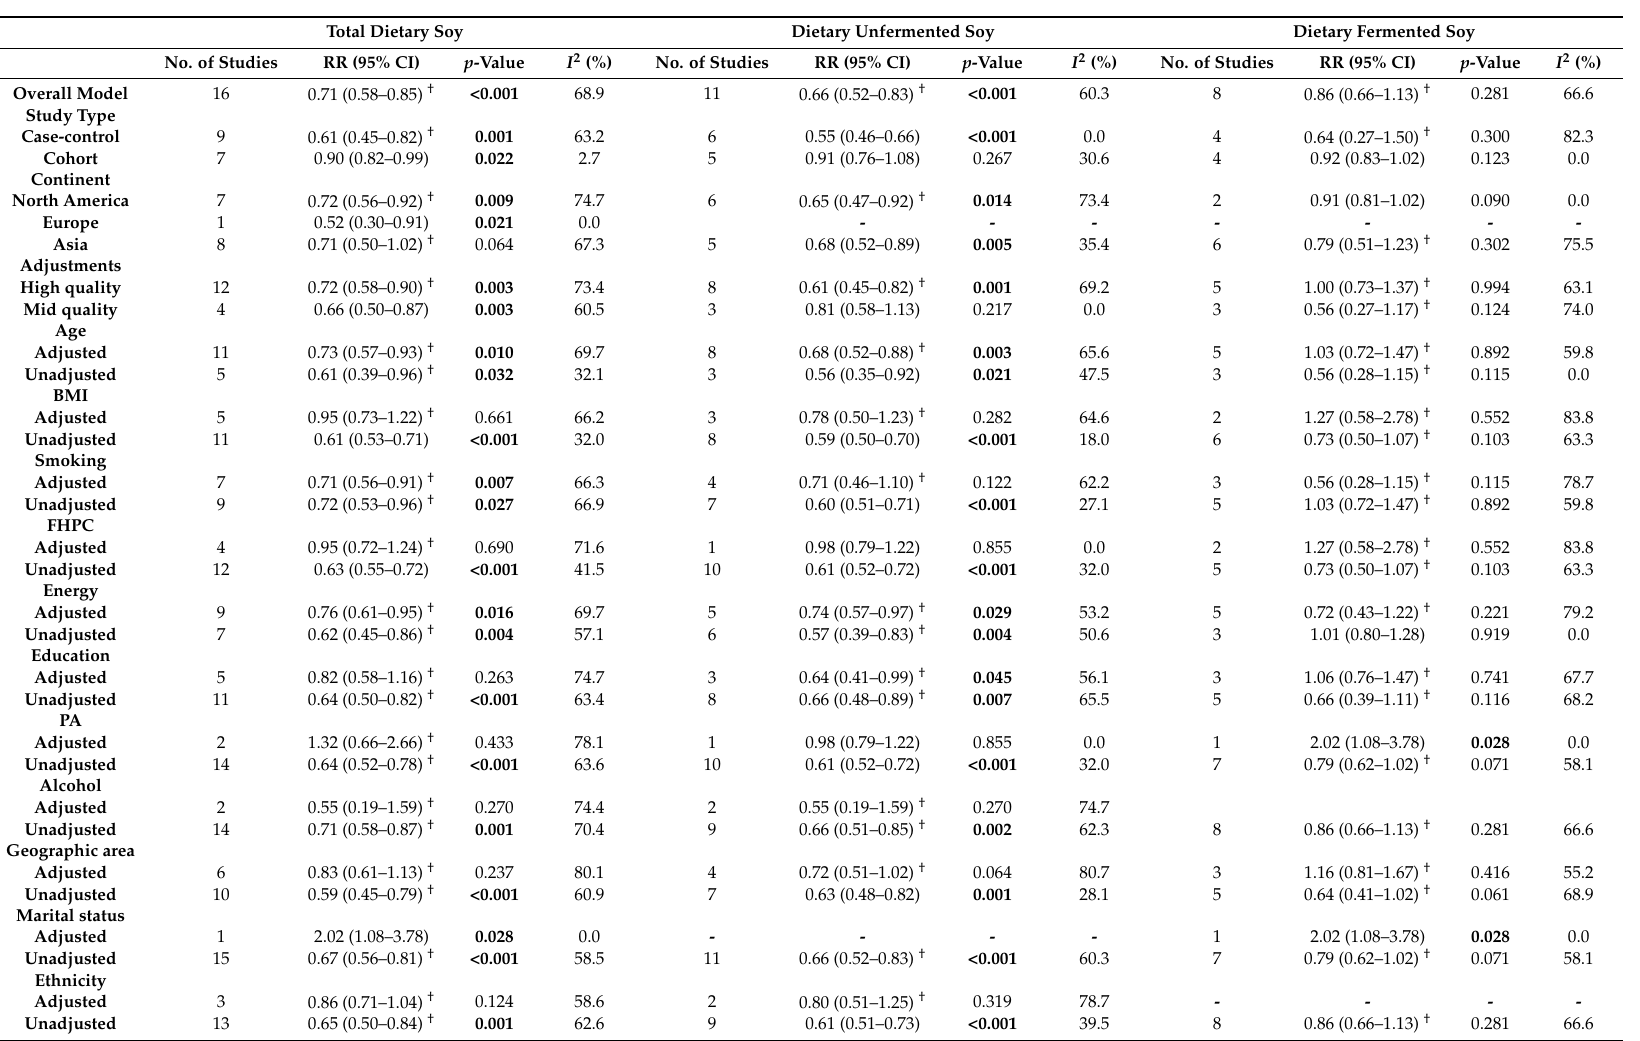
Table 2. Subgroup analysis of included studies. Bold values indicate p <